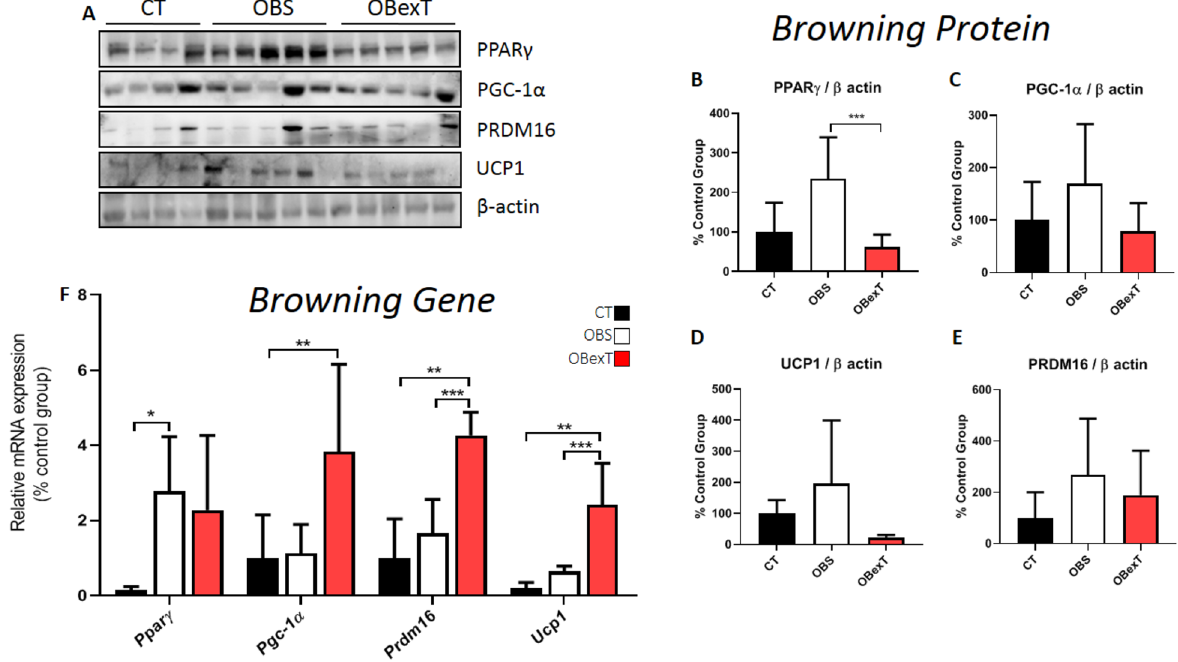
Figure 6. Total protein extract obtained from the subcutaneous adipose tissue was used for Western Blotting experiments. Uncut images can be viewed in the supplementary material. The membranes were cut at the specific height of the target protein. ( A ) The protein content of ( B ) PPARγ, ( C ) PGC-1α, ( D ) PRDM16, and ( E ) UCP1. The bars were relativized by the CT group (100%). In browning pathway, the signal of statistical difference are represented as follows * p < 0.05 CT versus OBS, ** p < 0.05 CT versus OBexT and *** p < 0.05 OBS versus OBexT (n = 4 CT group; n = 5 OBS group; n = 5 OBexT group). In ( F ), the effect of strength training of Pparγ , Pgc-1α , Prdm16, and Ucp1 . In browning gene, the signal of statistical difference are represented as follows * p < 0.05 CT versus OBS, ** p < 0.05 CT versus OBexT and *** p < 0.05 OBS versus OBexT (n = 7